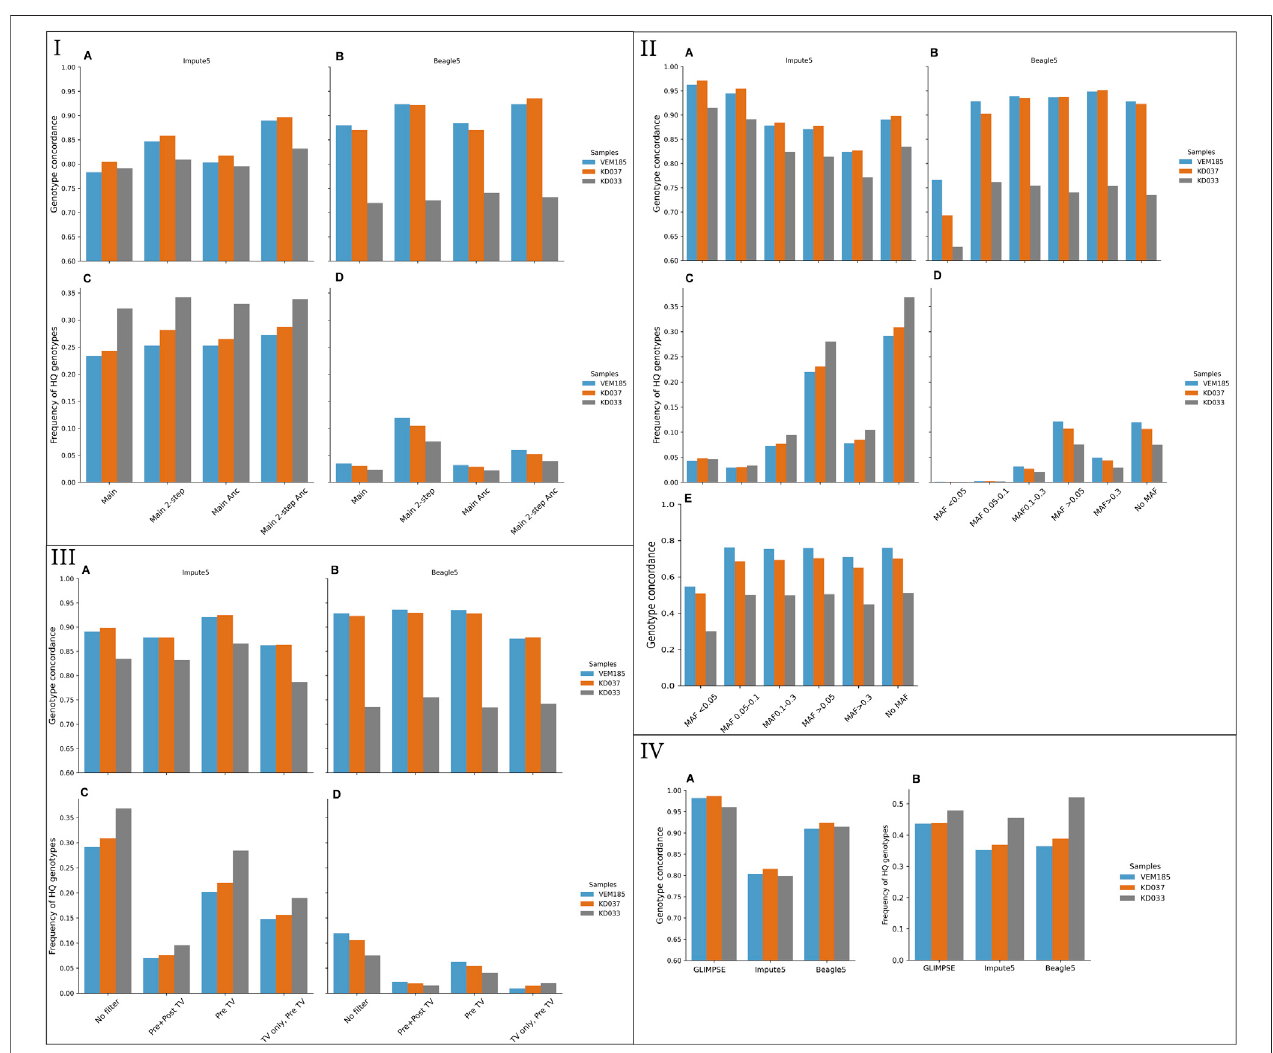
FIGURE 1 | Genotype concordance and fraction of high-quality (HQ) genotypes (portrayed in decimals, total HQ genotypes: VEM185: 4,701,683, KD037: 4,531,126, KD033: 3,887,848) using different imputation tools and reference panels. Imputed from 1× downsampled coverage genomes of VEM185, KD037, and KD033. I) Genotype concordance for Impute 5 (A) , Beagle5 (B) , Fractions of HQ genotypes covered by imputation in Impute5 (C) , and Beagle5 (D) . II) Genotype concordanceandFractionofHQgenotypesofvariousMAFbinsofMain+2-step+Anc+allreferencepanel.GenotypeconcordanceforImpute5 (A) ,Beagle5, (B) Fractions of HQ genotypes covered by imputation in Impute5 (C) , Beagle5 (D) and, Genotype concordance of only heterozygotic variants of various MAF bins imputed with Impute5 (E) . III) Filters on target downsampled vcf. Genotype concordance for Impute 5 (A) , Beagle5 (B) , Fractions of HQ genotypes covered by imputation in Impute5, (C) Beagle5 (D) .IV)Genotypeconcordance (A) andfractionofHQgenotypes (B) fromGLIMPSE,Impute5andBeagle5forMethod3.*Genotypeconcordance of Method 3 was done on all sites and cannot be directly compared to the other methods. Main, original one-step pipeline on main reference panel; 2-step, two-step pipeline with an extra fi ltering step; Anc, Ancient samples included in the reference panel; TV, transversions.